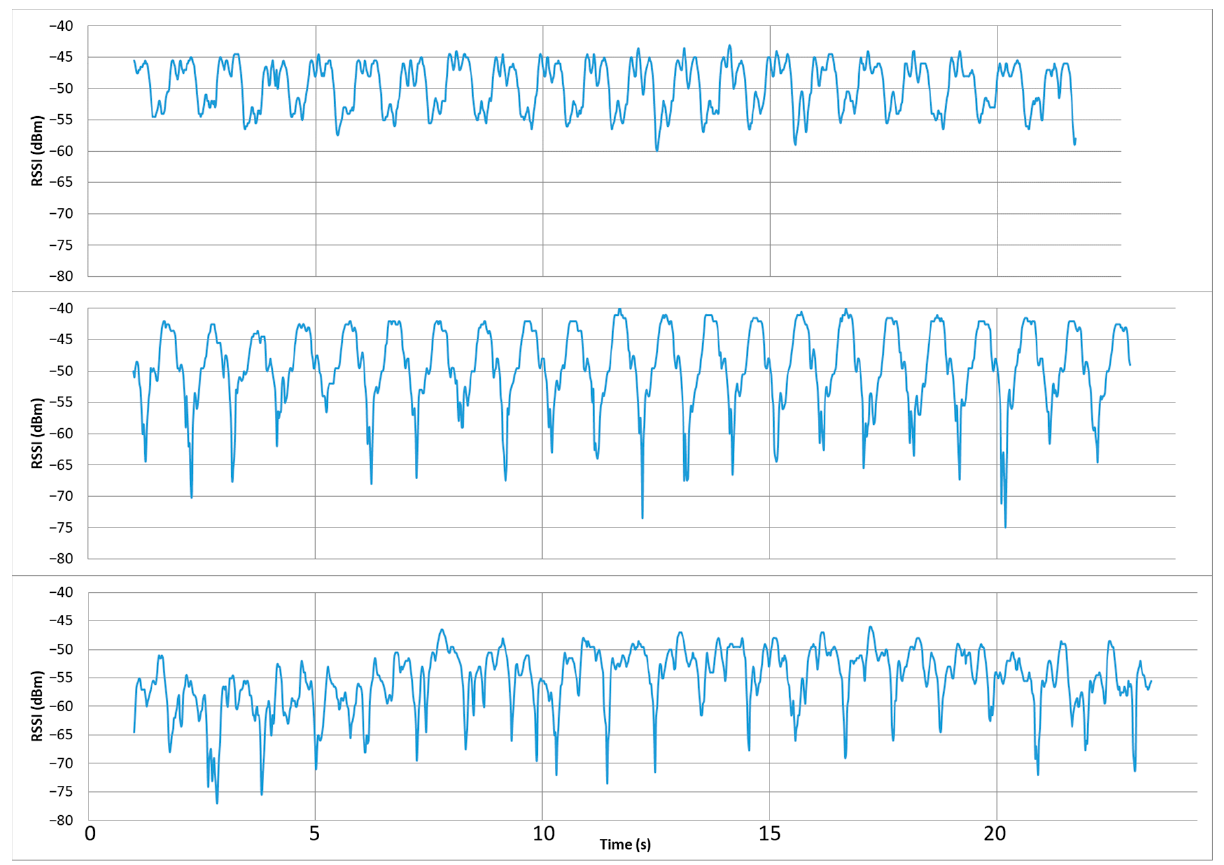
Figure 14. RSSI variation with time in the walking scenario for the three subjects on the 433 MHz band for − 2 dBm of transmit power and with the sender node located on the right wrist: ( top ) Subject A, ( middle ) Subject B, ( bottom ) Subject C.